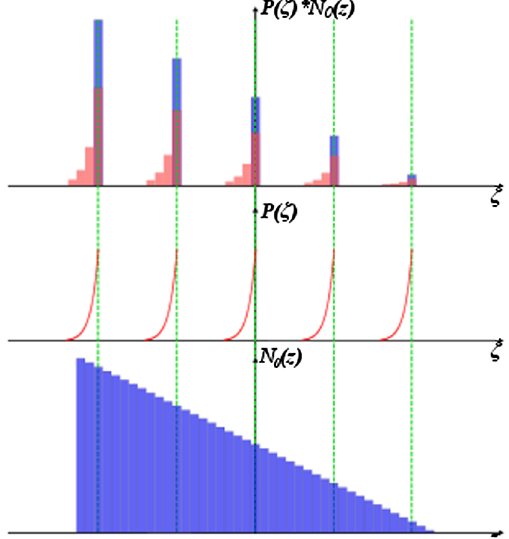
FIG. 15. The x 0 z 0 -series perturbation. Bottom: The ideal n 0 ð z i f Þ profile. Middle: The perturbation function P ð ζ Þ . Top: Slices of the ideal profile n 0 ð z i f Þ (blue) and the perturbed profile n ð z p f Þ (red). The Gaussian spread of the slices gets stronger the farther out from the